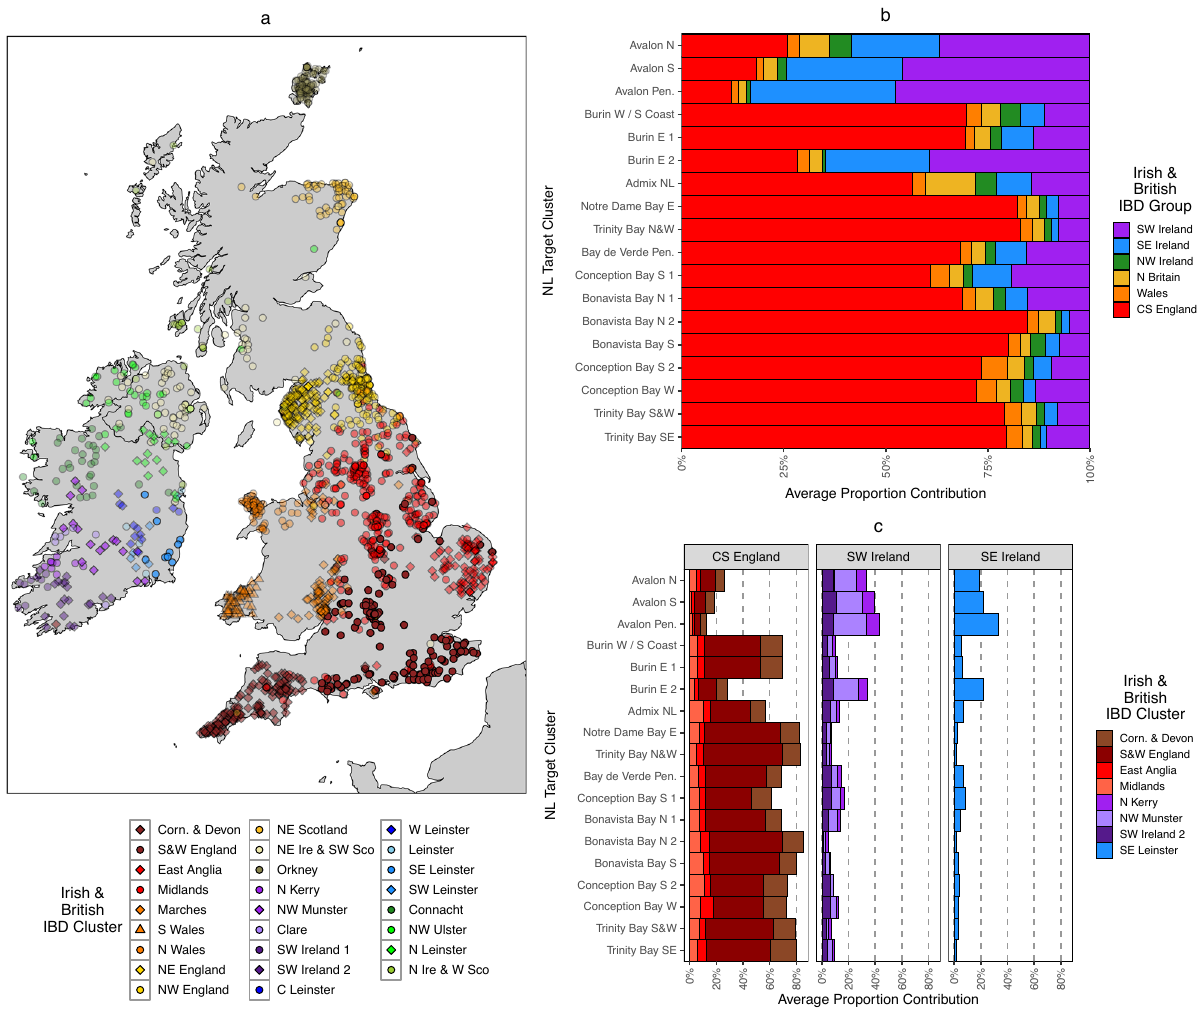
Fig. 3 Irish and British ancestry in Newfoundland and Labrador. a Map of Irish 23 and British 22 individuals placed according to recent mean ancestral birthplace, colour and shape coded according to IBD-network clustering. Colours are used to group hierarchically related clusters together (see “ Methods ” ). A slight transparency for individual points has been introduced proportional to the maximal proportion that each cluster contribute to any one NL cluster, with great contributors having less transparency. b The summed proportions of the estimated ancestry proportions calculated from Irish or British IBD-segments shared with NL. Contributions from individual IBD clusters are summed together in groups according to Irish or British region. c Individual Irish or British IBD cluster contributions to NL ancestry proportions, showing only clusters that contribute >5% to any one NL cluster. All panels were plotted using the statistical computing language R 63 and the packages ggplot2